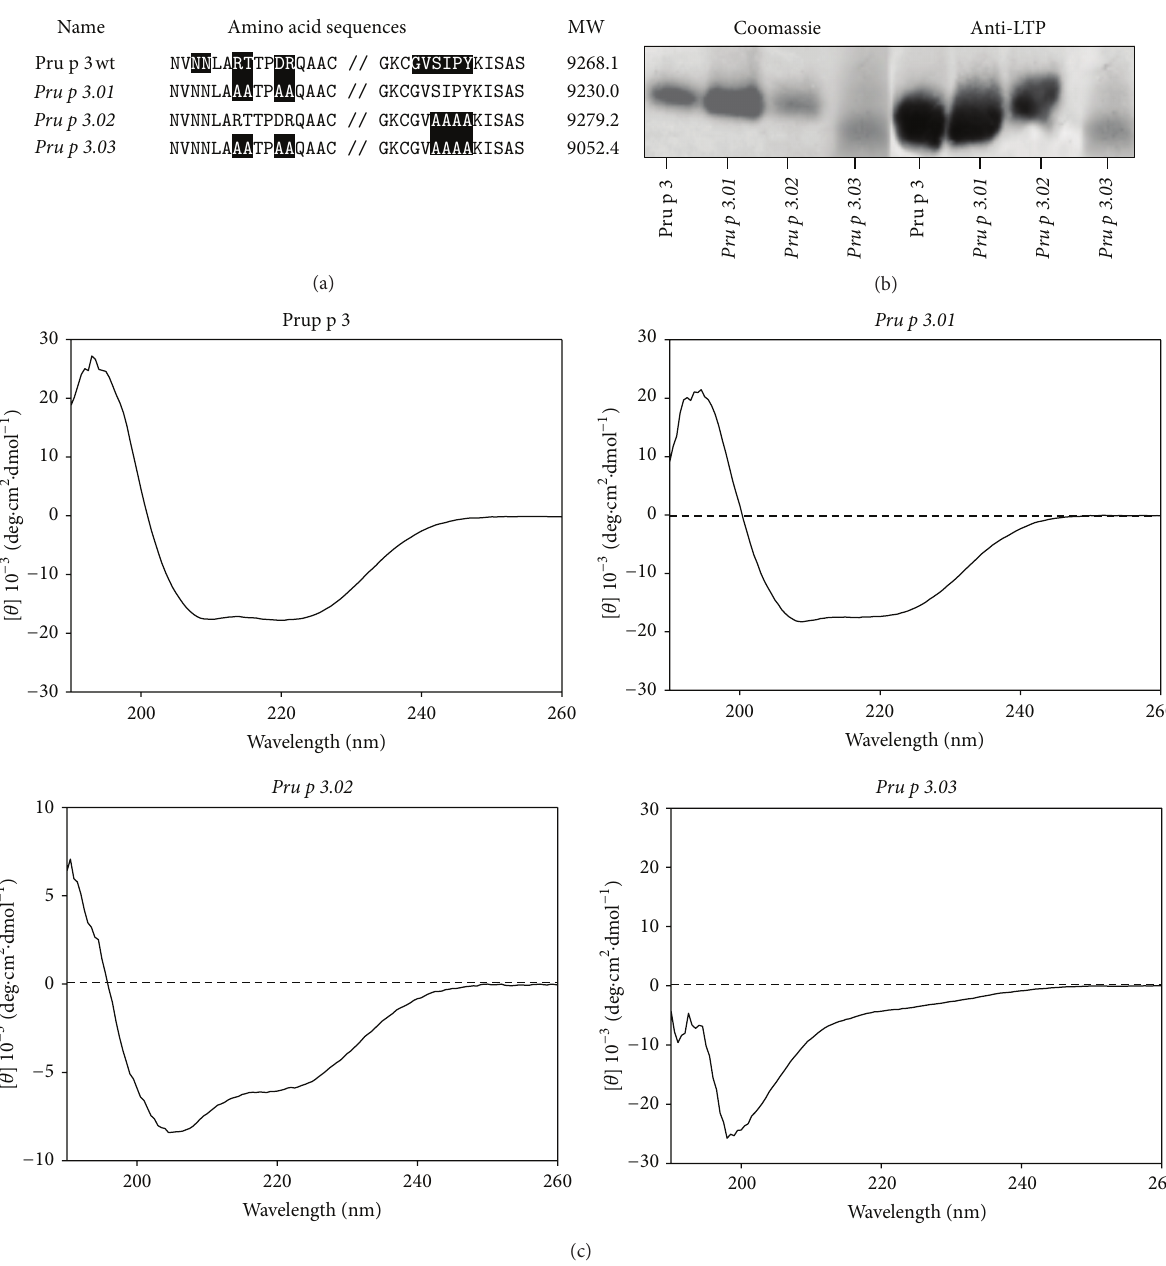
Figure 1: (a) Alignment of amino acid sequences of the wild type (Pru p 3) and mutant forms ( Pru p 3.01, Pru p 3.02 ,and Pru p 3.03 ). The residues shaded in black correspond to the IgE epitope in Pru p 3 or the modified residues in Pru p 3.01, Pru p 3.02 , and Pru p 3.03 . The molecular weight (MW) obtained by mass spectrometry is indicated. (b) The recombinant proteins (3 𝜇 g) were separated by SDS-PAGE and stained with Coomassie Blue (Coomassie) or immunodetected with anti-Pru p 3 antibody (anti-LTP). (c) Far-UV (190–260 nm) CD spectrum of purified